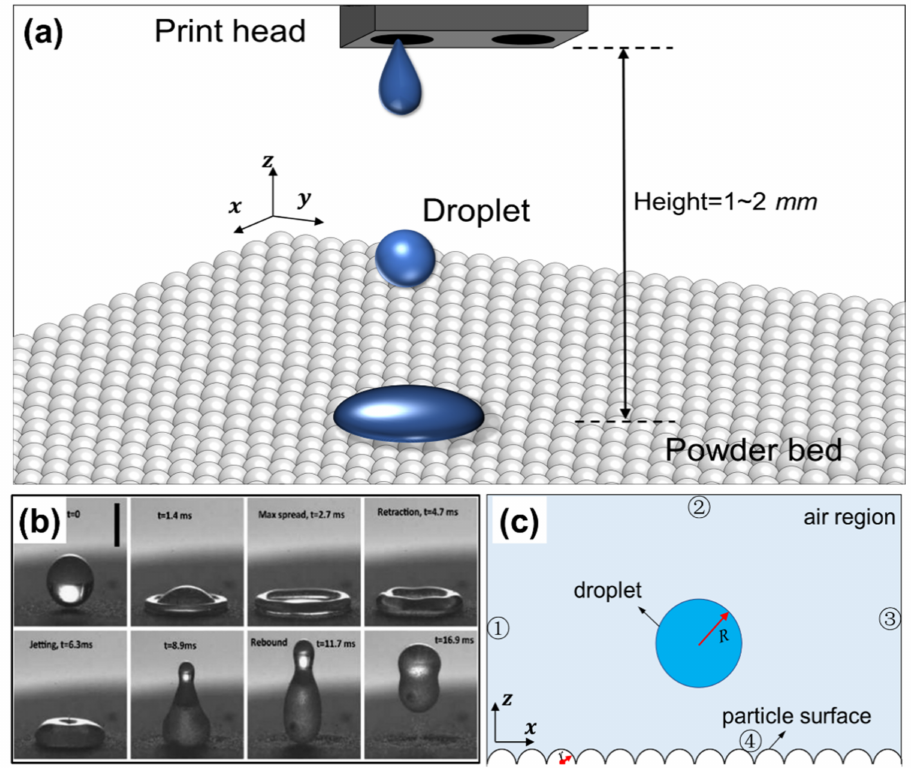
Figure 2. The modeling of binder droplets impact in 3D printing. ( a ) is the schematic illustration of binder droplets impact on powder bed in the 3D printing. ( b ) is the sequence of events for the typical low impulse droplet impact. ( c ) is the two-dimensional numerical simulation